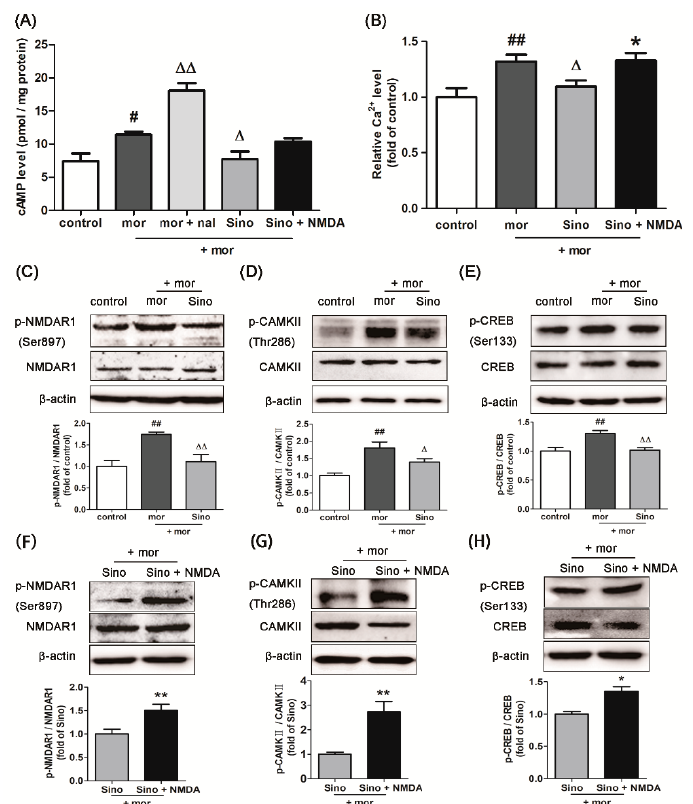
Figure 3. Intervention of sinomenine on morphine-treated SH-SY5Y cells. ( A ) Sinomenine decreased the level of cAMP in the morphine-treated SH-SY5Y cells ( n = 3). SH-SY5Y cells were pretreated with 100 μ Msinomenine for 12 h and then incubated with 100 μ M morphine for 48 h. NMDAR agonist was incubated with SH-SY5Y cells treated with morphine and sinomenine for 12 h. Naloxone was incubated with SH-SY5Y cells treated with morphine to allow withdrawal for 20 min before evaluation. mor: morphine; nal: naloxone; ( B ) Sinomenine decreased the level of intracellular Ca 2+ in the morphine-treated SH-SY5Y cells ( n = 3); ( C – E ) Sinomenine suppressed the expression of p-NMDAR1/NMDAR1, p-CAMKII/CAMKII, and p-CREB/CREB, as detected by Western blotting in the morphine-treated SH-SY5Y cells ( n = 3); ( F – H ) NMDAR agonist reversed the